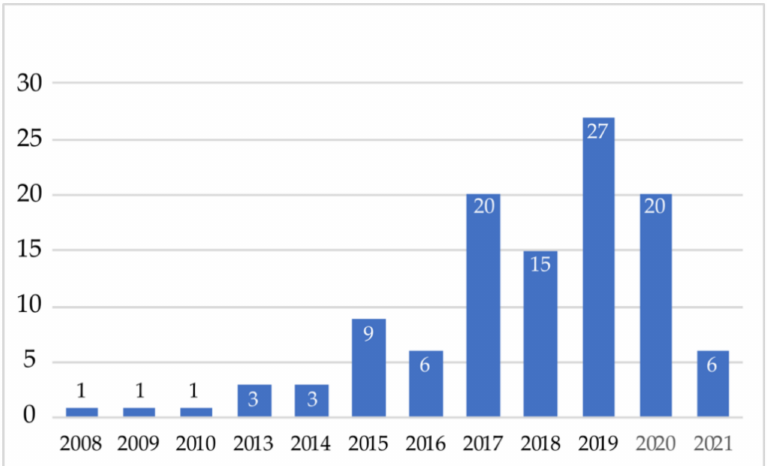
Figure 2. Amount of 3D-printed constructions recorded by year of execution or